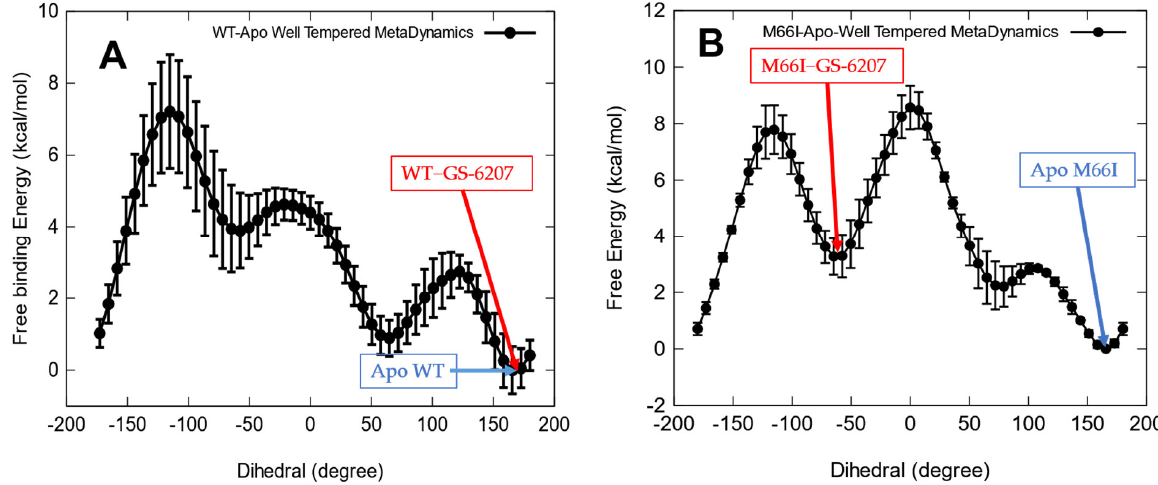
Figure 8. Time course of the   torsion in the side chain of I66 of the M66I CA mutant after the PF74 is manually removed (red), M66I−PF74 complex (black). is manually removed (red), M66I − PF74 complex (black).